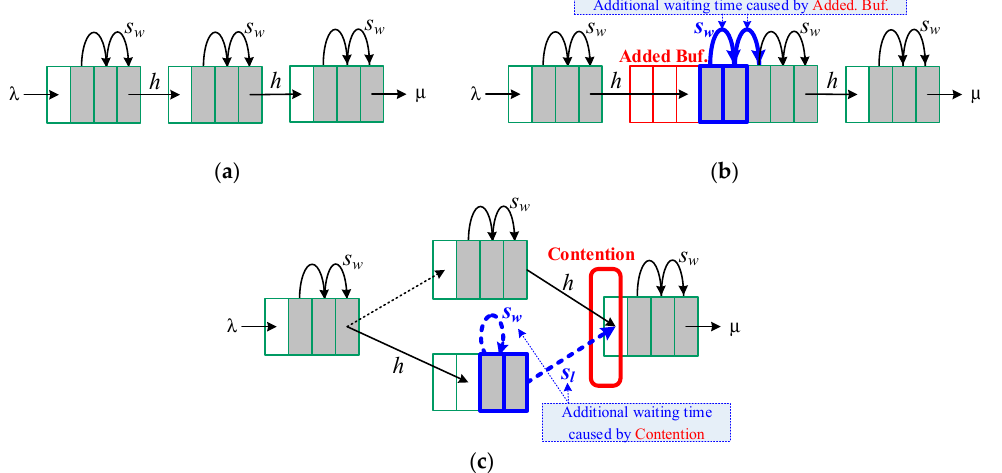
Figure 5. Latency analyses in cases of ( a ) a single path with a buffer size of twelve, ( b ) a single path with a buffer size of sixteen, and ( c ) two alternative paths with a buffer size of sixteen. The packet arrival rate is close to the packet service rate in a congested network. The throughputs in ( a,b ), and ( c ) are similar, but the latency in ( a ) is less than the latencies in ( b , c ).